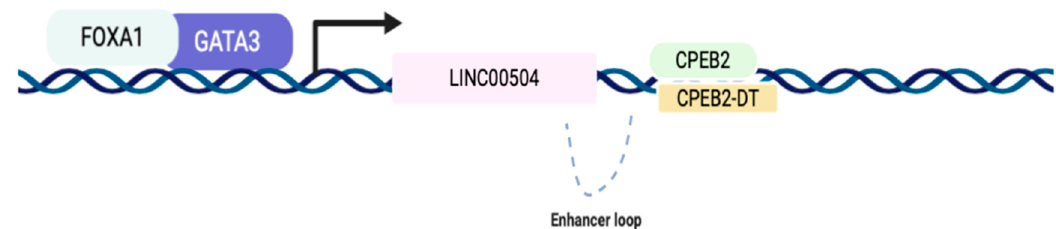
Figure 6. Scheme of transcriptional regulation mediated by GATA3 and FOXA1 in the promoter region of LINC00504. From public data from ChIP-Seq, it was identified that these transcription factors (TF) bind to the promoter region of LINC00504, possibly activating its transcription. These TFs were also identified in the LINC00504 co-expression network.